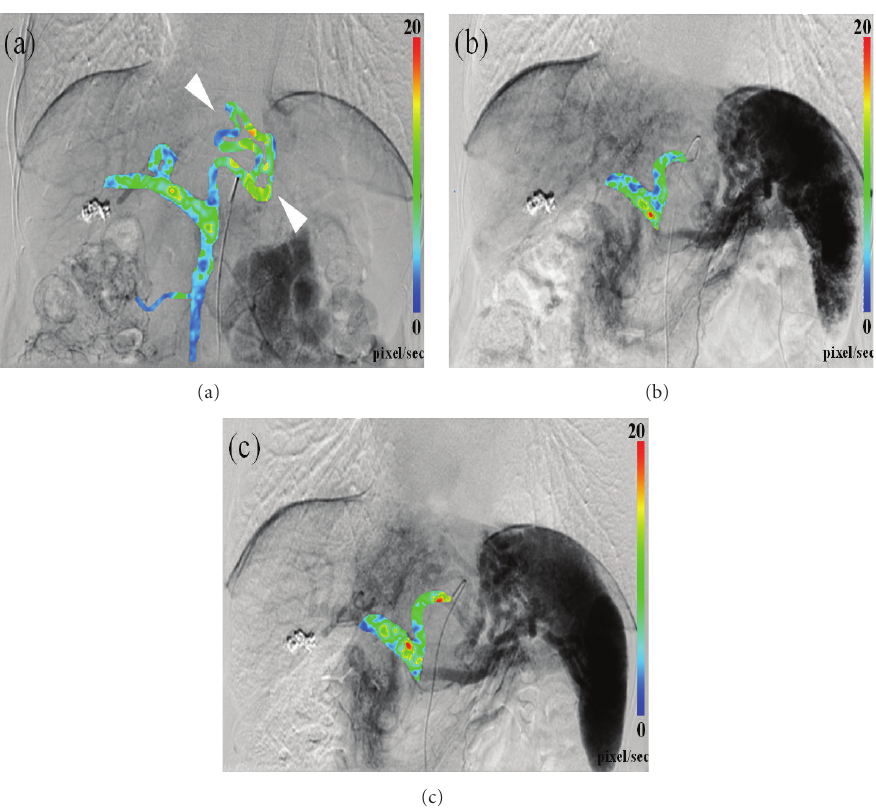
Figure 2: An example of the blood flow distribution with color coding. (a) The portal vein flow image with the contrast injected in SMA. (b) The portal vein flow image before TACE with the contrast injected in celiac axis. (c) The portal vein flow image after TACE with the contrast injected in celiac axis.